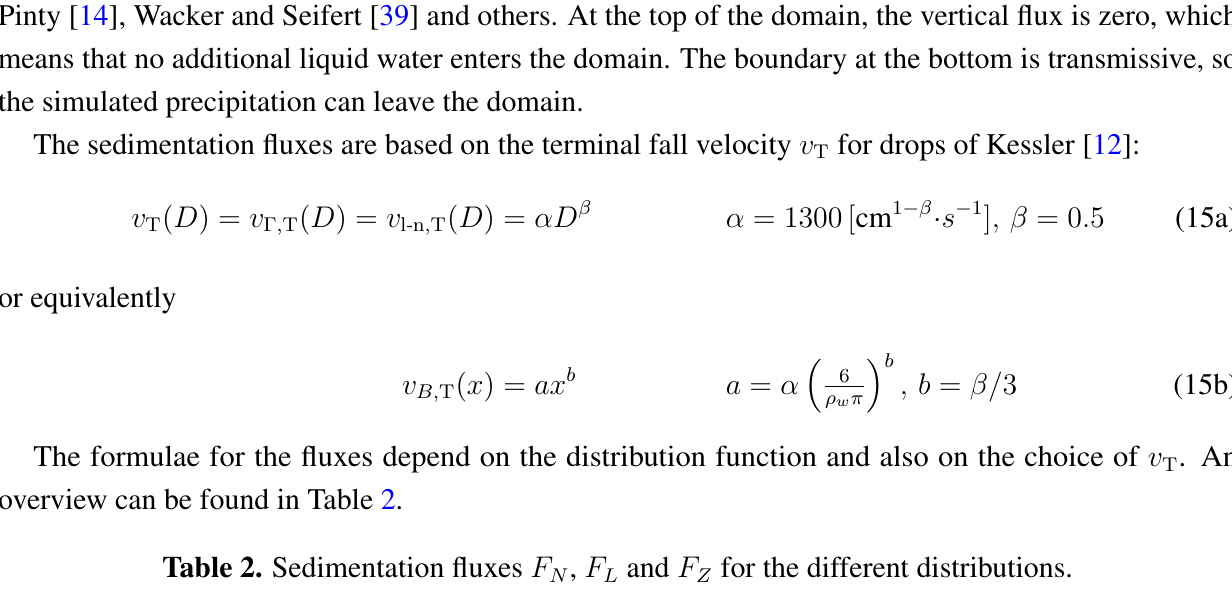
Table 2. Sedimentation fluxes F